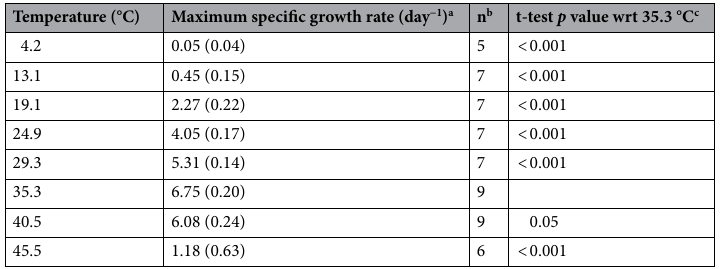
Table 1. Maximum specific growth rate of dilute Picochlorum celeri in DISCOVR medium, constant light and 35 PPT marine salt concentration as a function of temperature. a Standard error is given in brackets. b n represents the number of replicates for each condition. c Gives the t-test p value for each concentration with respect to growth rates at 35 °C.